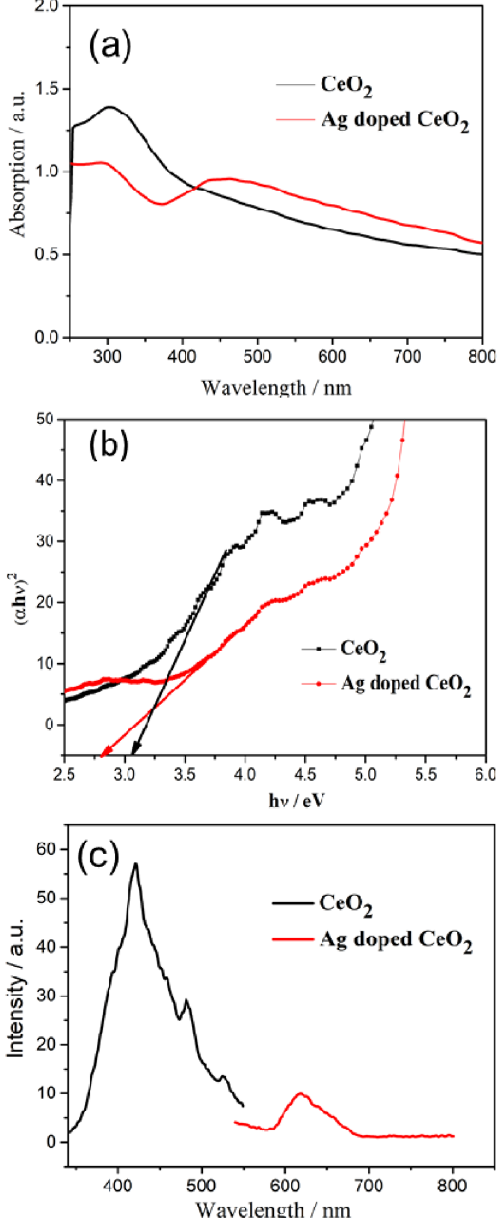
Figure 6. Optical absorption of pure CeO 2 and Ag decorated CeO 2 nanoparticles, ( a ) UV–Vis spectra, ( b ) Tauc plot and ( c ) PL